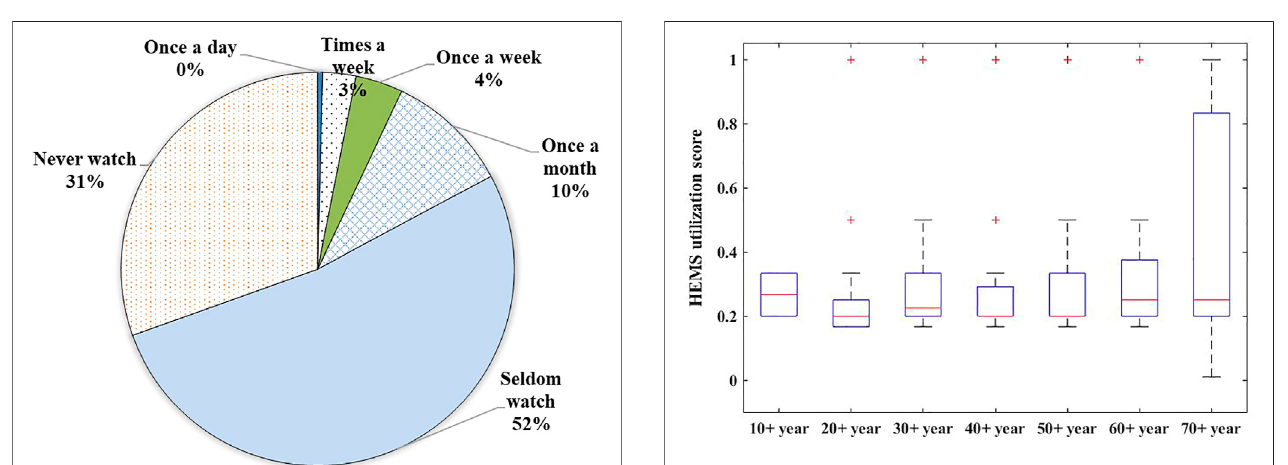
FIGURE 12 | Variations in HEMS utilization scores of different age